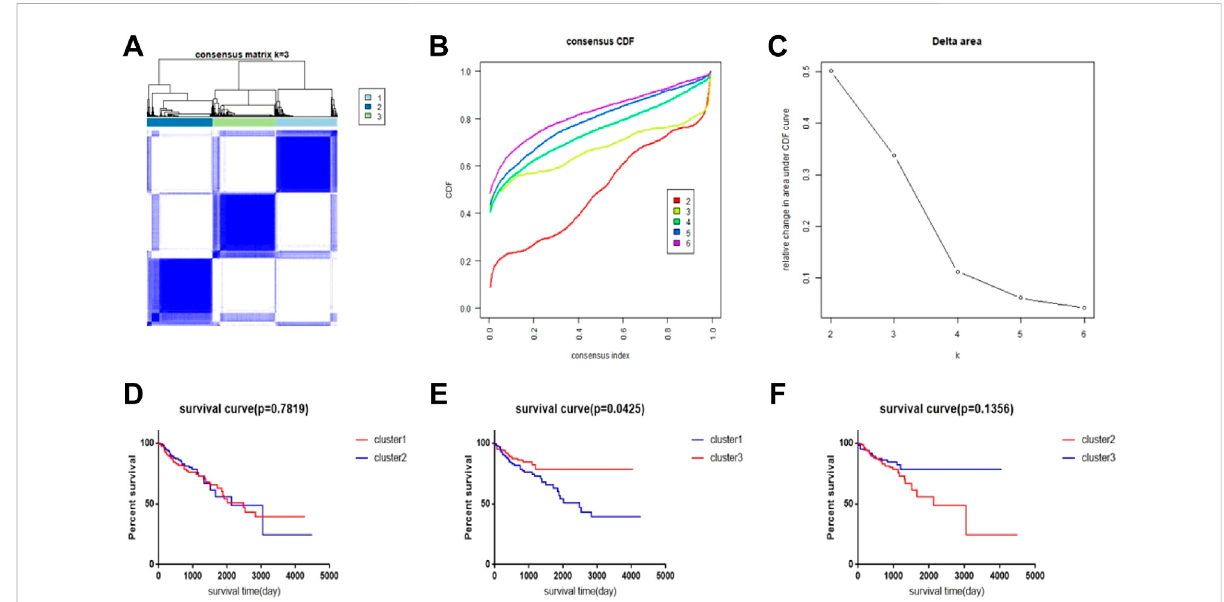
FIGURE 1 CRC subtype characteristics and difference in overall survival (OS). (A) Consensus clustering analysis yields three matrices, each representing one CRC subtype. (B) Consensus clustering cumulative distribution function (CDF) for k = 2 – 9. (C) Relative change in area under the CDF curve for k = 2 – 6. (D – F) Survival time curve between 3